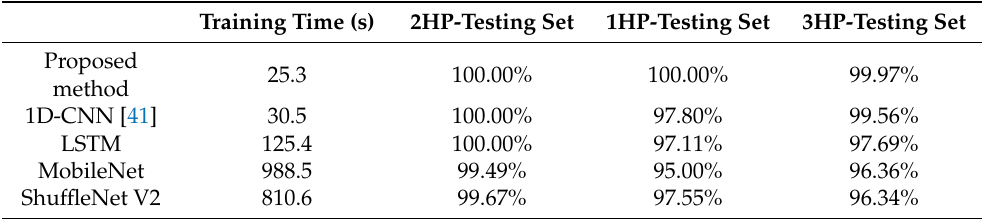
Table 6. The training time of each model and the identification accuracy rate of the test set under different loads. Training Time (s) 2HP-Testing Set 1HP-Testing Set 3HP-Testing Set Proposed method